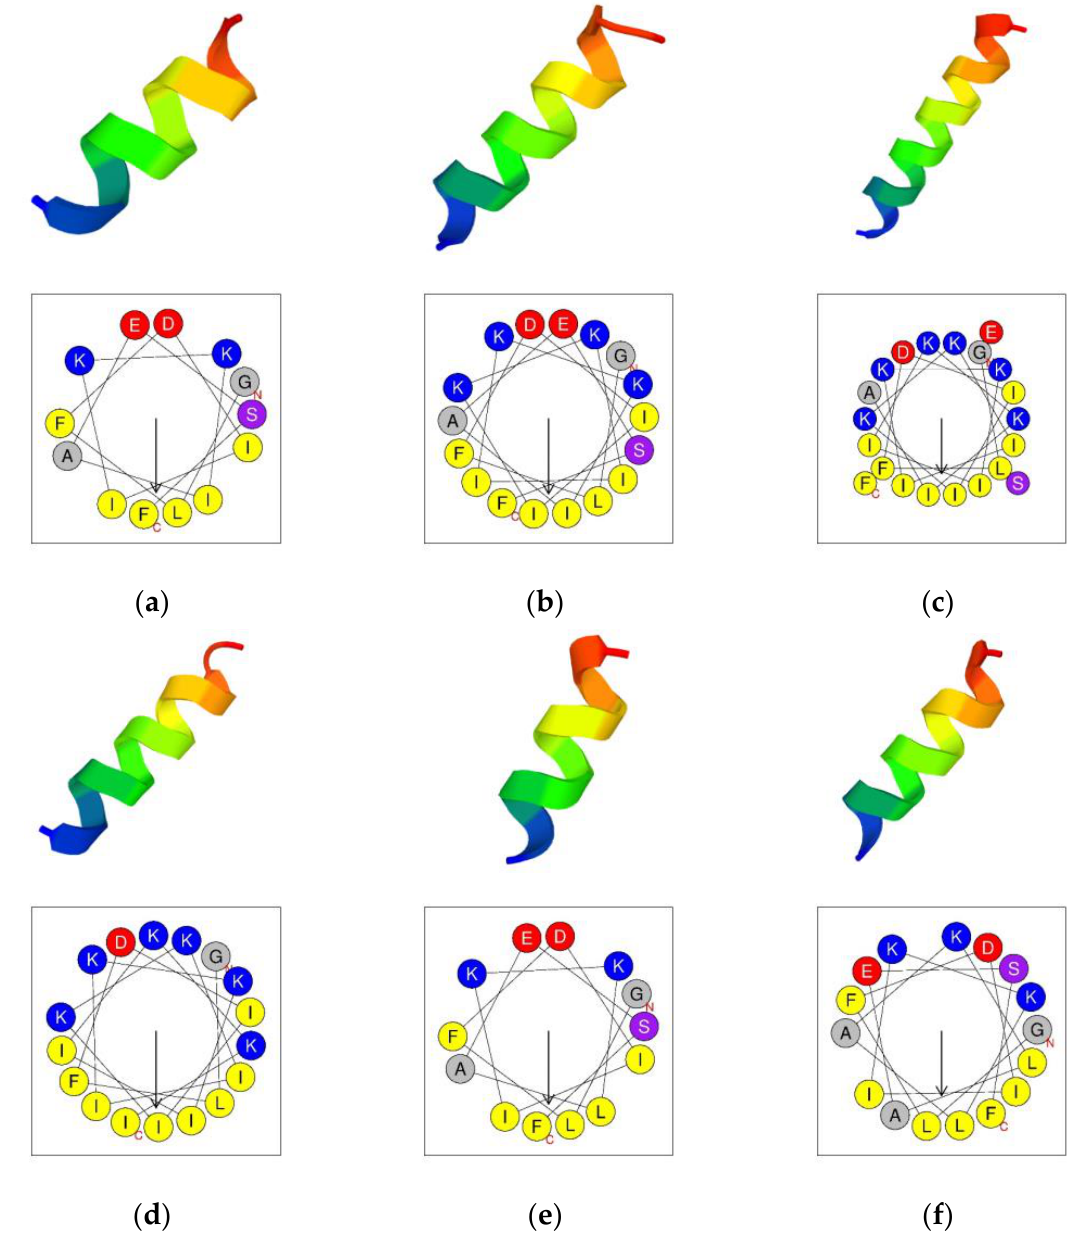
Figure 2. The predicted 3D secondary structure of the peptides from PEP-FOLD3 (above) and the helical wheel projection of the peptides (under). ( a ) aurein 1.2; ( b ) IK-1; ( c ) IK-2; ( d ) IK-3; ( e ) KLA-1; and ( f ) KLA-2. The helices are rainbow-colored with N-terminus (blue) and C-terminus (red). In the helical wheels, the C-terminals and N-terminals are indicated by “C” and “N”, respectively. The arrow in the middle of the circle indicates the hydrophobic direction formed by amino acids with high hydrophobicity. The yellow circles represent the hydrophobic amino acids. The grey circles represent the neutral amino acids. The blue circles represent the polar amino acid residues.